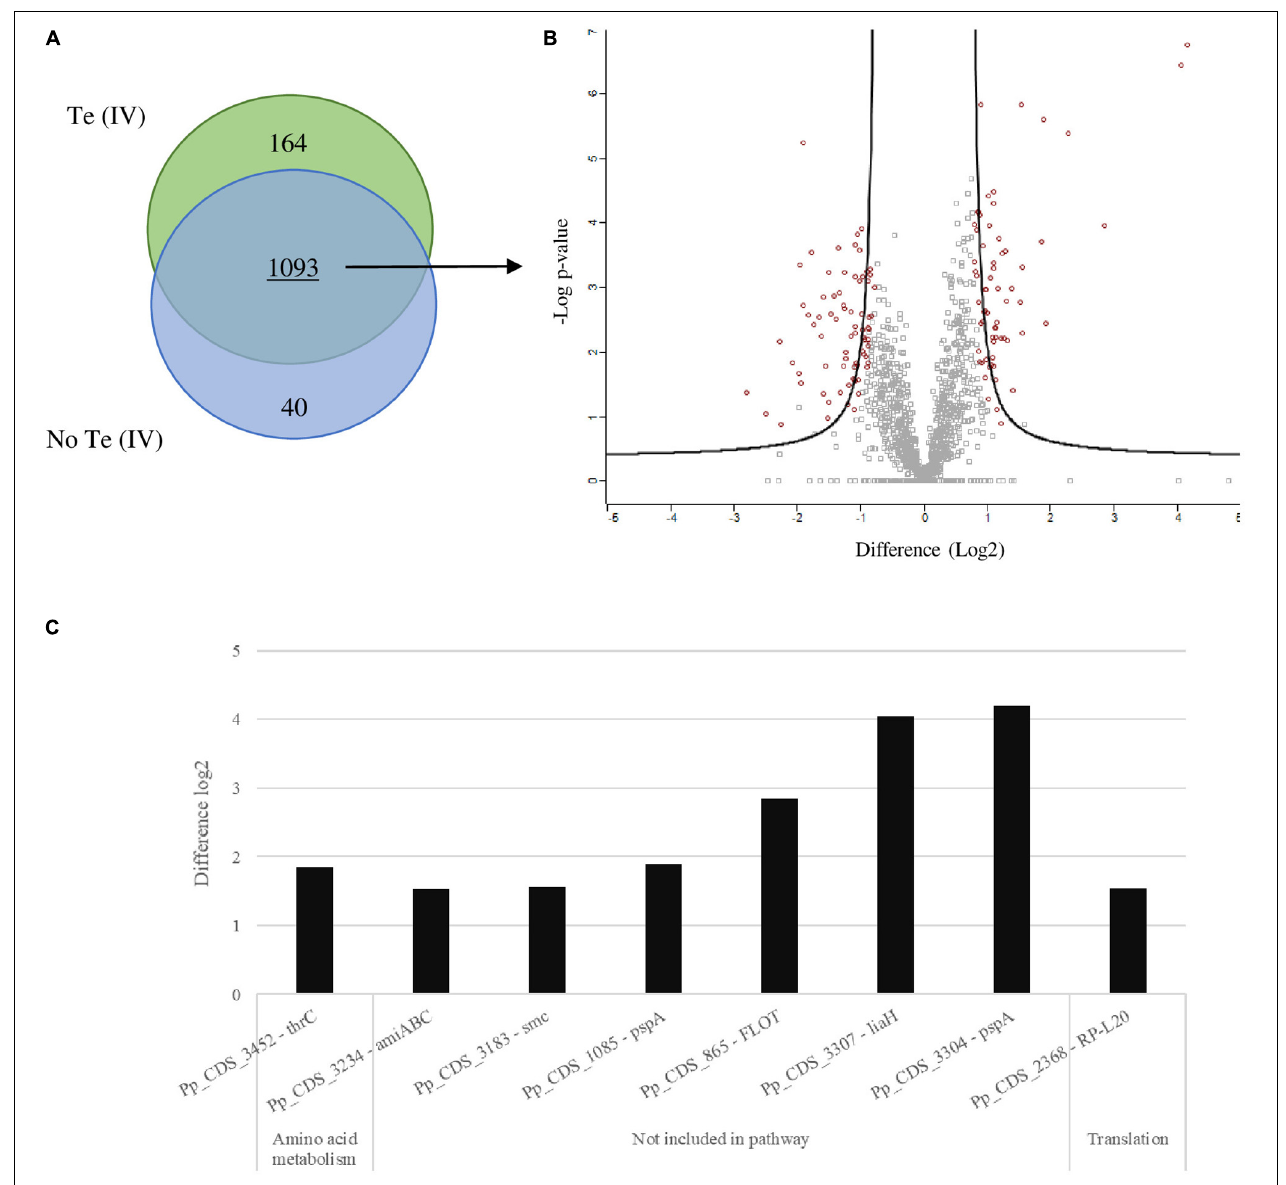
FIGURE 3 | Differential proteomics in Paenibacillus . Schematic representations of the determination of significant change in abundance (SCA) of proteins obtained for growth of Paenibacillus pabuli ALJ109b in Control [without Te (IV)] and 5 × 10 − 4 M of Te (IV). Each test condition was performed in triplicate. (A) Venn diagram representing the total proteins obtained, exclusive to each test and combined. (B) Volcano plot showing total shared proteins between tests (Welsh t test; FDR-0.05; S0 > 1), those with SCA indicated by large red circles. (C) Highest overexpressed proteins (log2 over 1.5) result from LC-MS analyses; proteins are grouped according to KEGG functional